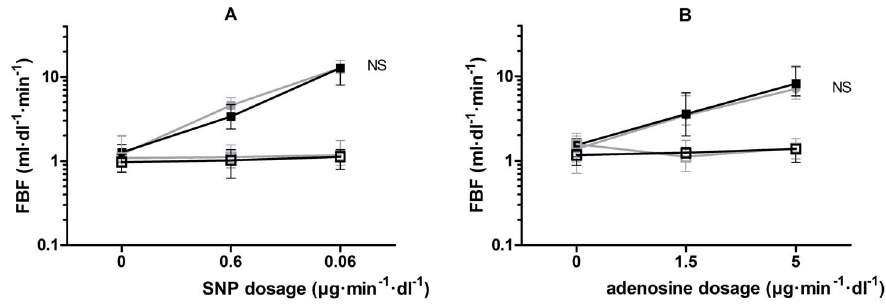
Figure 5. FBF response to sodium nitroprusside (SNP) and adenosine. The FBF response to A sodium nitroprusside (SNP) and B adenosine, during placebo (grey) and eplerenone (black) treatment in the experimental arm (filled squares) and non-experimental arm (open squares).